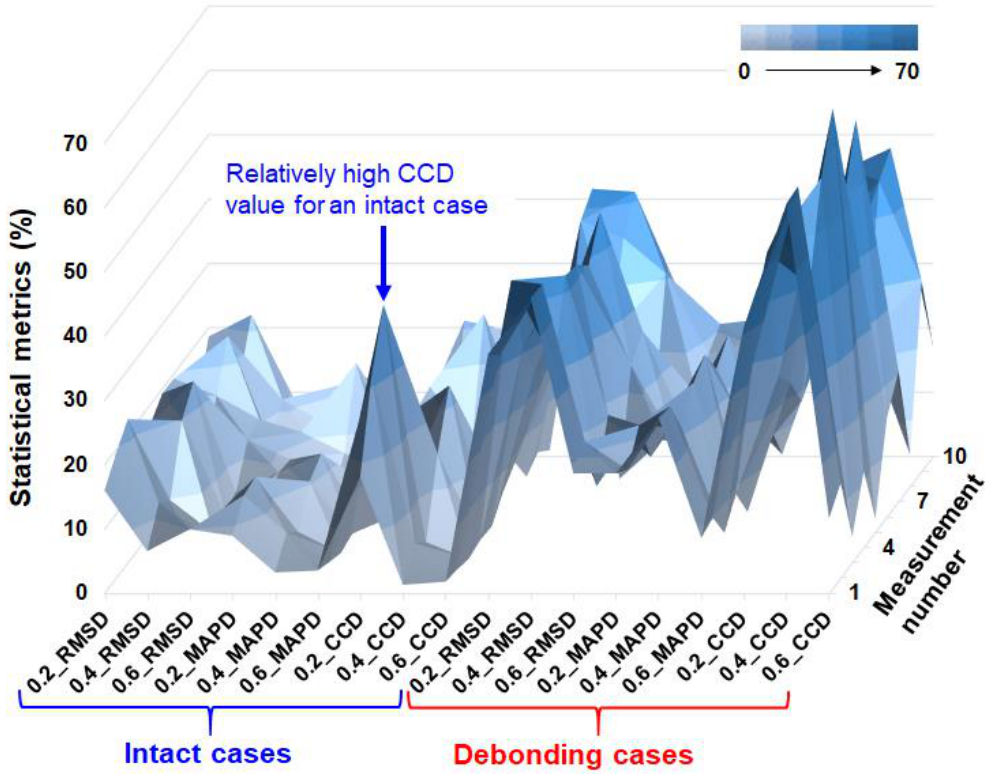
Figure 4. Surface type plot of the statistical metrics obtained from experiments. Table 1. Results for 0.2 mm thickness top composite plate.